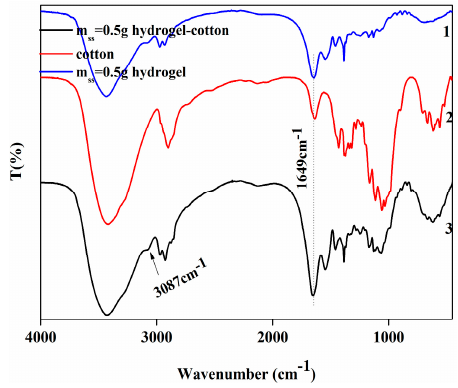
Figure 11. The FT-IR of (1) m ss = 0.5 g hydrogel (2) cotton (3) m ss = 0.5 g hydrogel cotton.